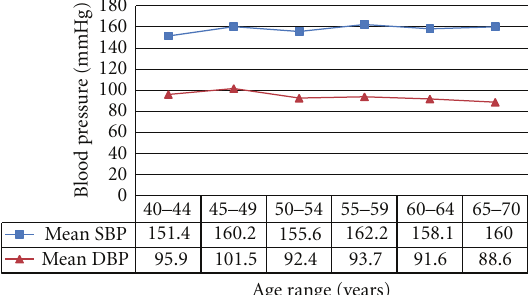
Figure 1: Trend of mean SBP and mean DBP with